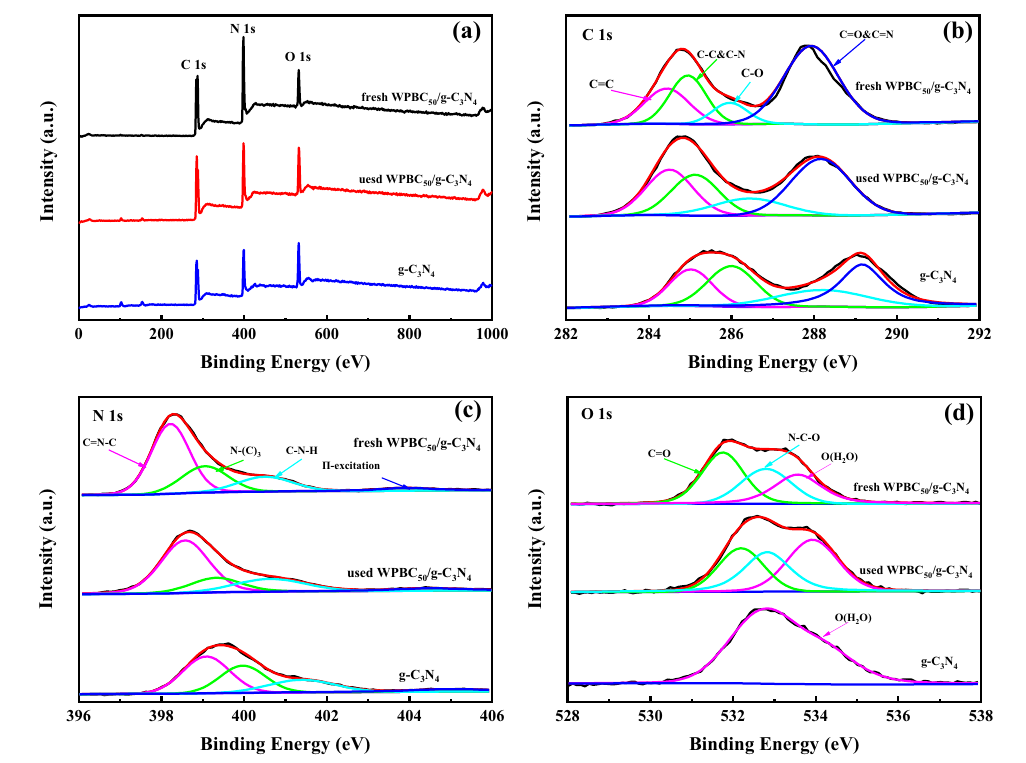
Fig. 10 XPS spectra of fresh WPBC